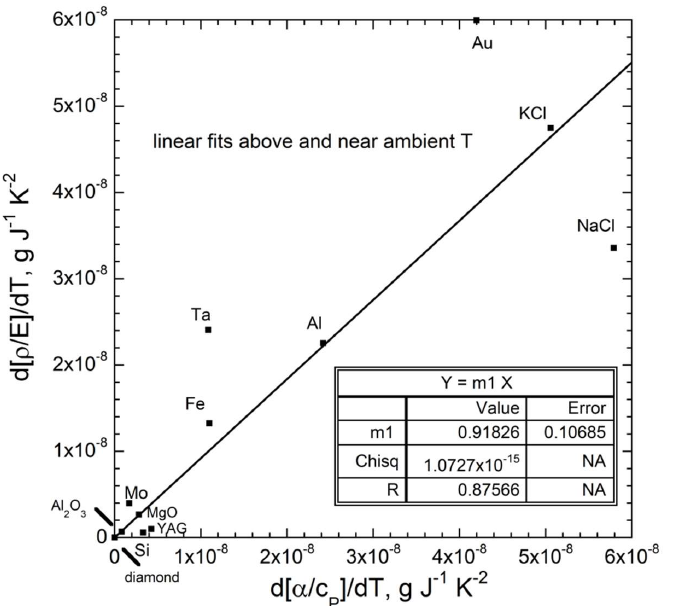
Figure 17. Comparison of the temperature dependence of the RHS and LHS of Equation (43). The effect of structure is not included. Data for these solids are described in Figure 16 and Appendix A.